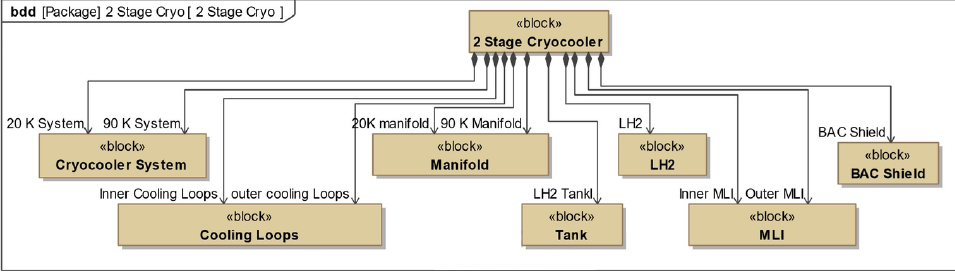
Figure 12. Two stage thermal management system